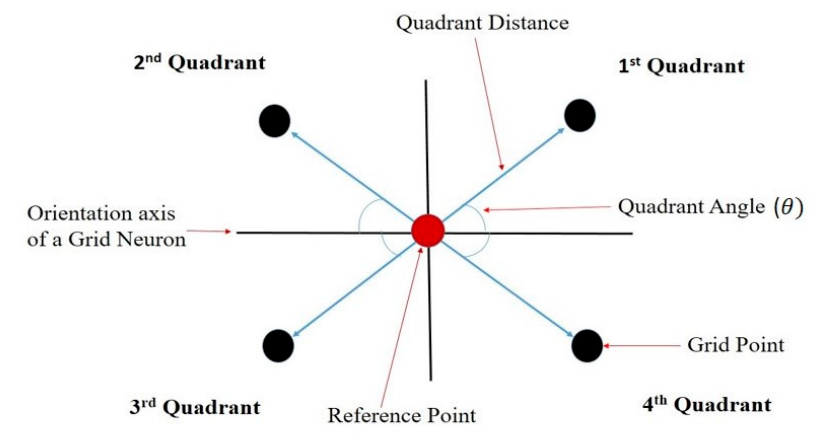
Figure 7. Geometry of quadrants.